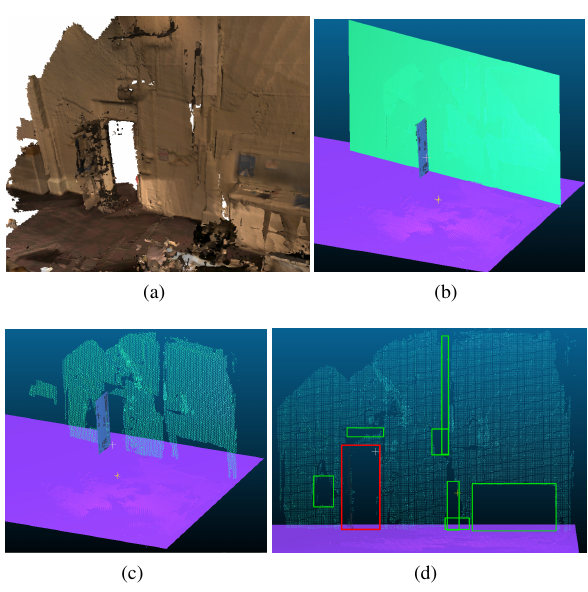
Figure 8: Door detection. (a) 3D mesh provided by the Tango. (b) Corresponding patches of the fl oor, the door and the wall contain- ing it. (c) Points describing the wall in the mesh. (d) Empty areas (green) in the set of coplanar points including the door